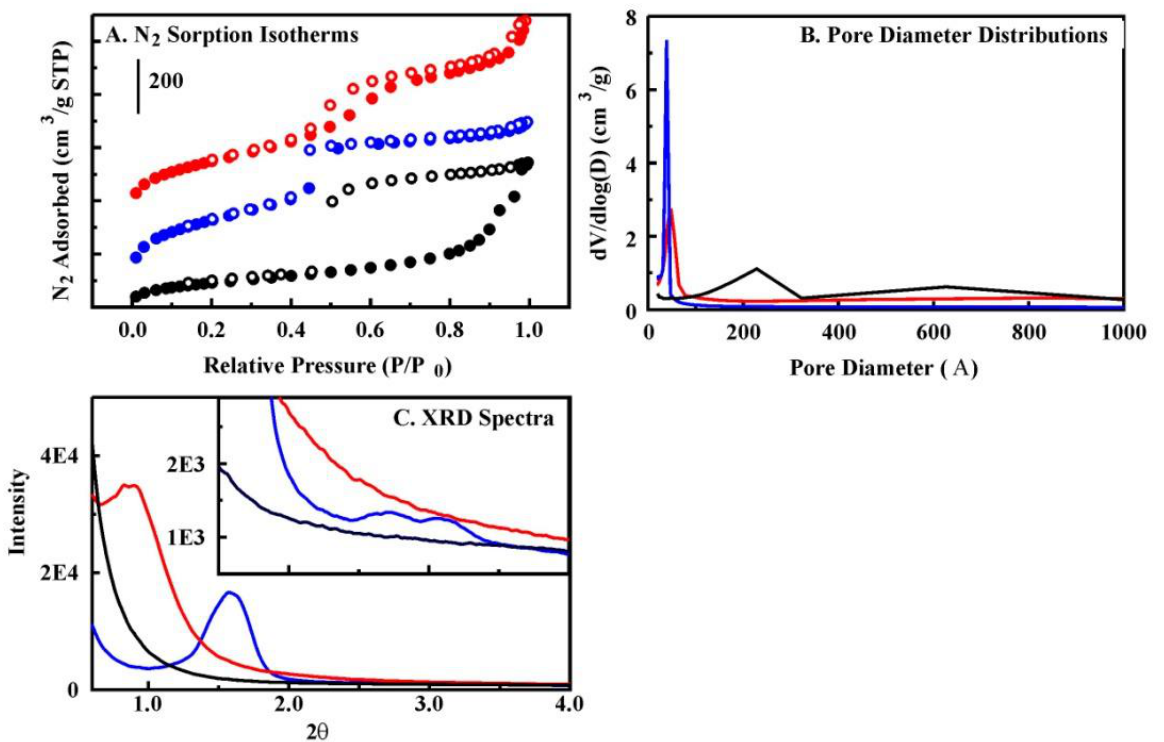
Figure 3. Structural characterization. Panel A, nitrogen sorption isotherms (BP2 offset by 325 cm 3 /g). Panel B, pore size distributions. Panel C, XRD spectra. B100 (blue), BP2 (red), OTS